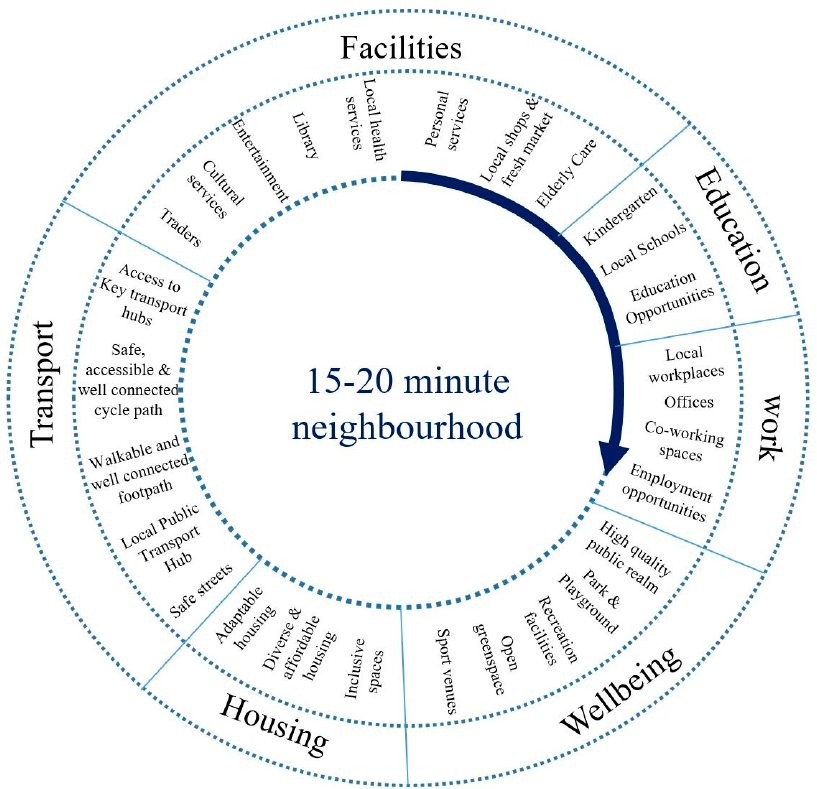
Figure 3. Key principles of creating a 15–20 min neighbourhood.